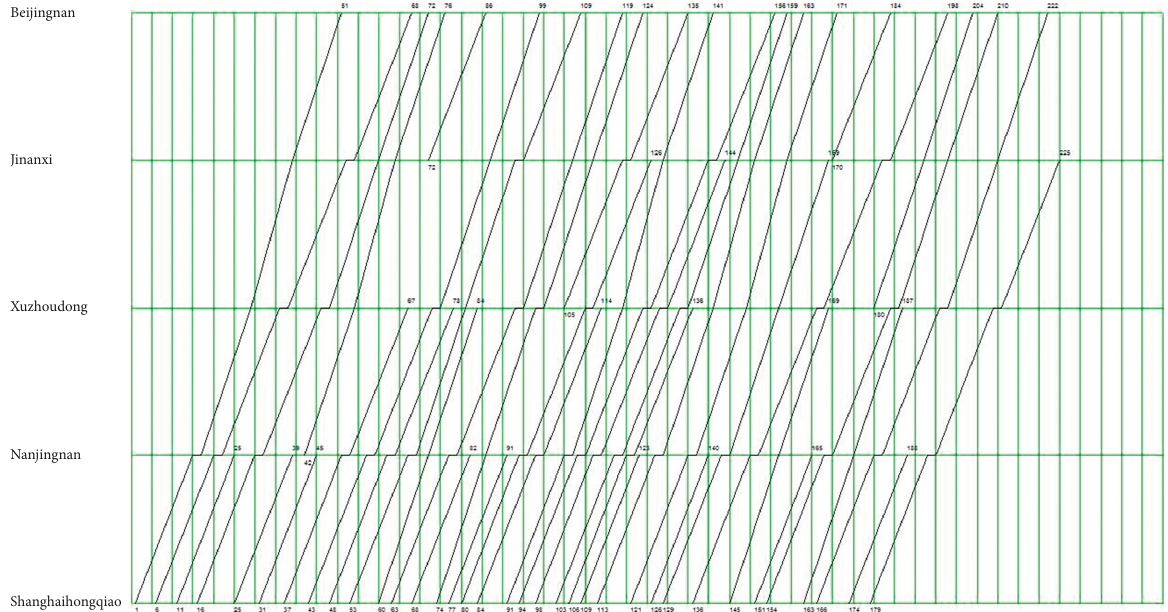
Figure 5: The prescribed timetables of existing trains in the